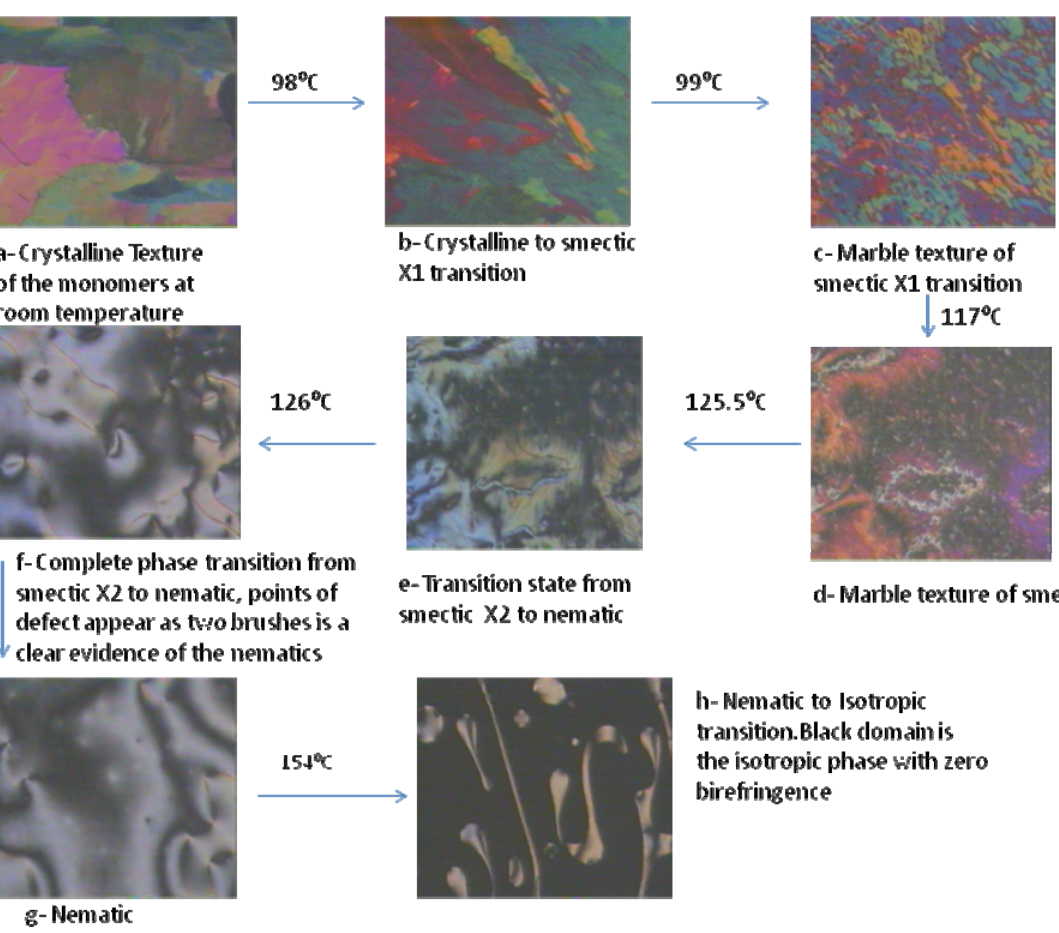
Figure 4. Liquid crystalline transitions for the compound 2 as observed under light polarized microscopy, crossed polarizer, magnification ×